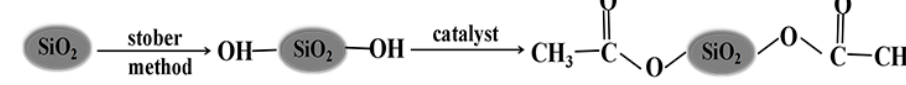
Figure 1. The treatment of diatoms.